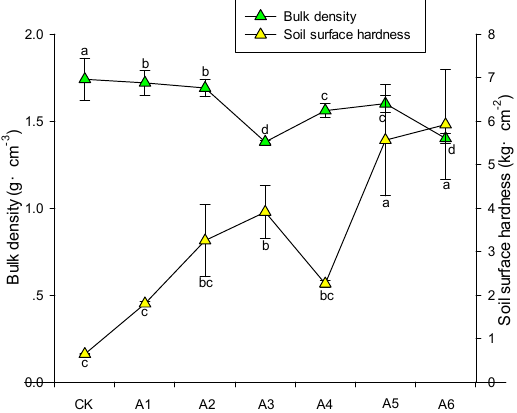
Figure 11. Relationship between poplar age and soil bulk density and soil surface hardness. Means with different letters indicate significant differences at p < 0.05. Vertical bars represent ± standard deviation.